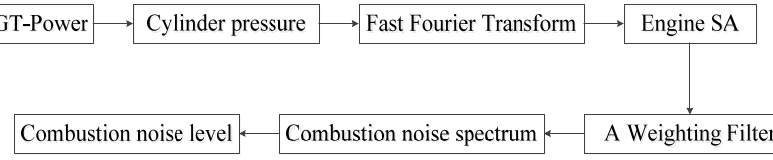
Figure 5. Combustion noise level calculation.